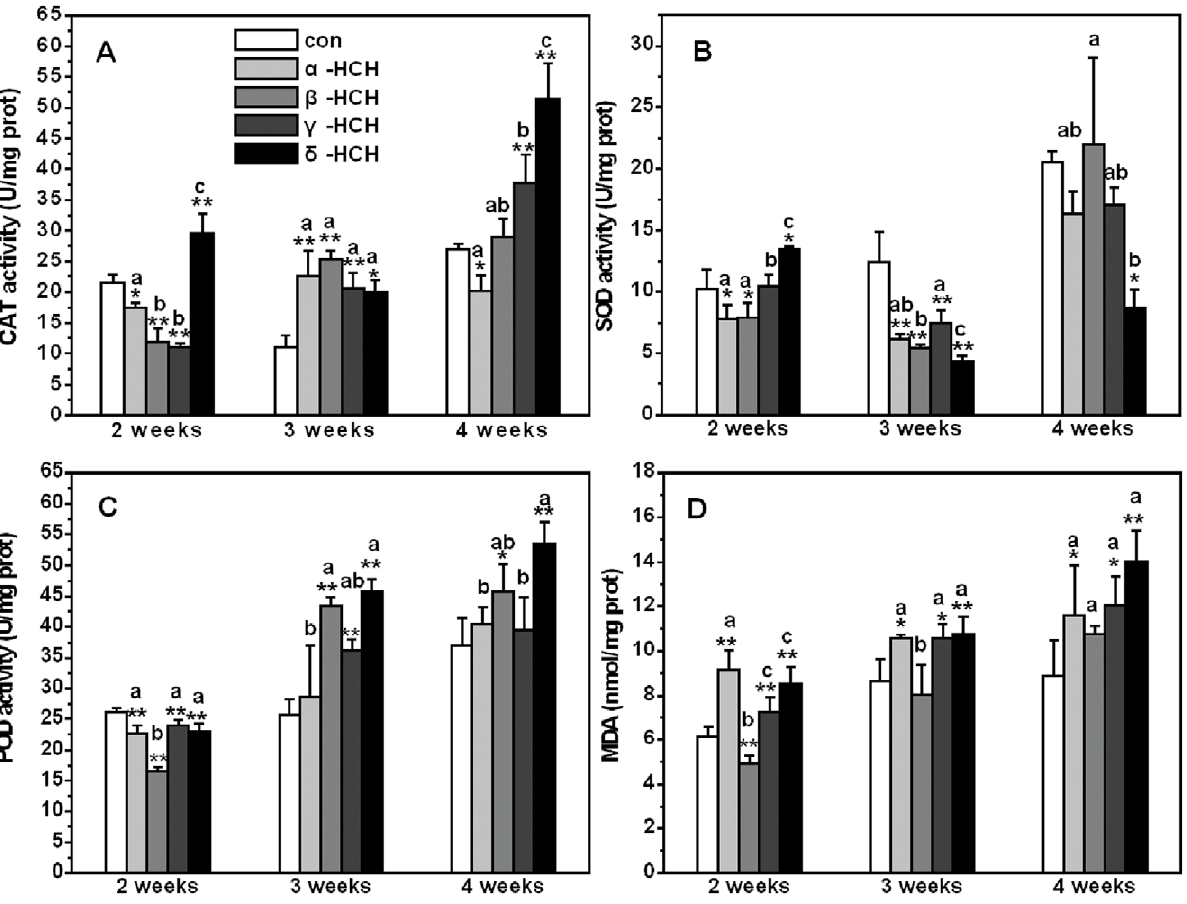
Figure 6. Activity of anti-oxidative enzymes and malondialdehyde content in Arabidopsisthaliana after different exposure time. (A) Activity of catalase (CAT); (B) Activity of superoxide dismutase (SOD); (C) Activity of peroxidase (POD); (D) Malondialdehyde (MDA)